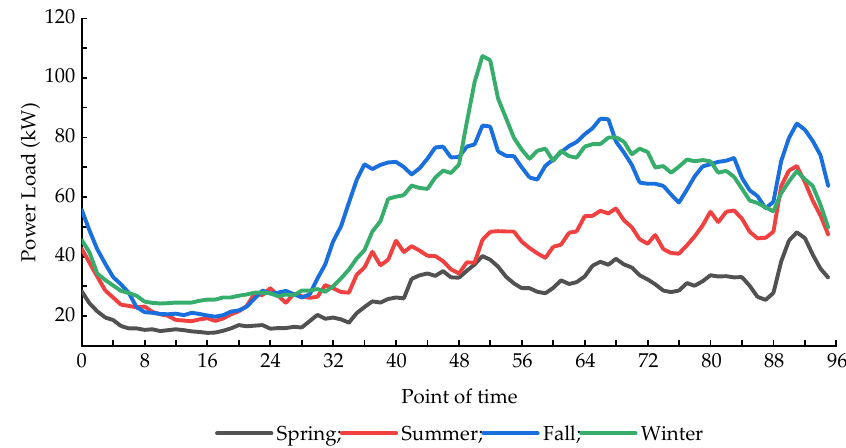
Figure A2. Average electric vehicle charging load for each season.